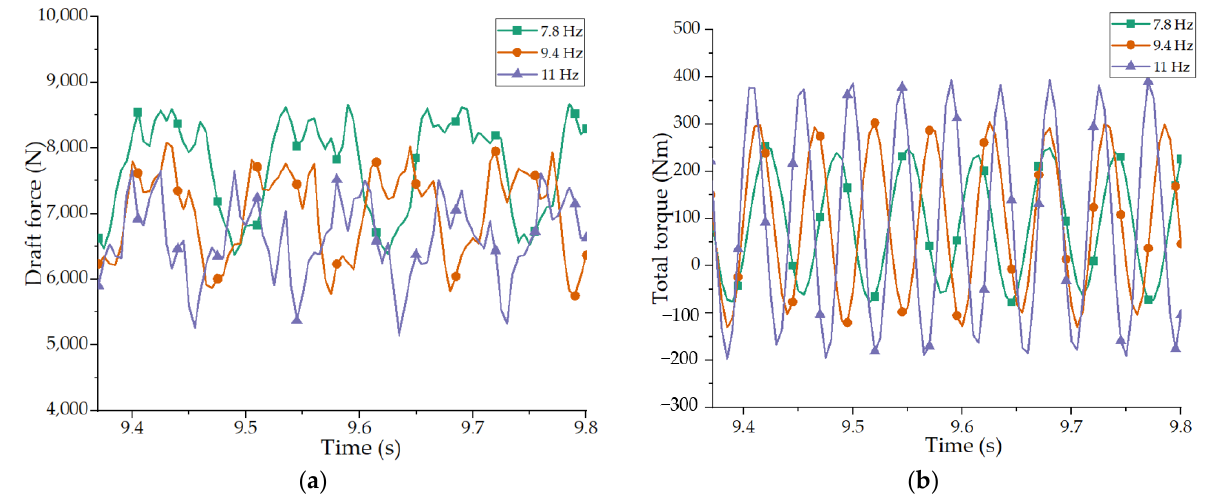
Figure 10. Effect of vibration frequency on harvester performance: ( a ) Draft force; ( b ) Total torque.